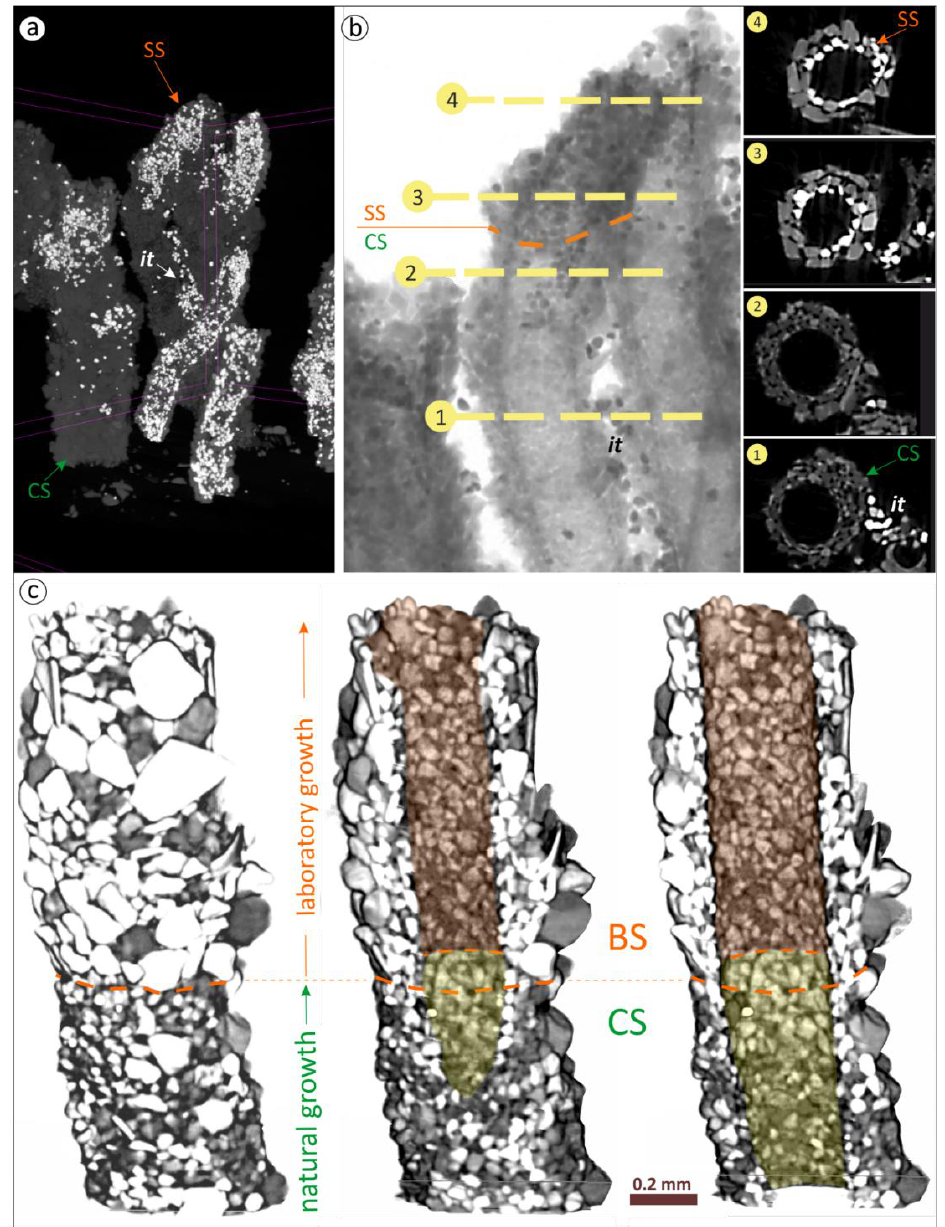
Figure 9. Image results obtained by microtomograph analysis of a tube grown in tanks 2 and 3. ( a ) A 3D view of the tubes set grown in tank 2 using the siliciclastic sand (SS). The grains of magnetite and pyroxene are highlighted by a brilliant white color. They formed tubes as a continuation of pre-existing tubes (Calcilithic sand (CS)) or by the accretion of new tubes. The SS also filled the intertube areas (it). ( b ) Projection image. The orange dotted line indicates the moment in which the test started. Lines 1 and 2 indicate cross-sections of the tubes grown in a natural environment, and lines 3 and 4 indicate cross-sections of the tubes developed in the tank; note the evident variation in the density of the grains (denser sands are dark grey). ( c ) In tank 3 (bioclastic sand (BS)), the start of the test coincided with an abrupt change in the diameter of the tube. In addition, grain size increased in the upper portion of the tube, while the void containing the worm showed a constant diameter. The thickness of the portion grown in the laboratory was clearly increased.